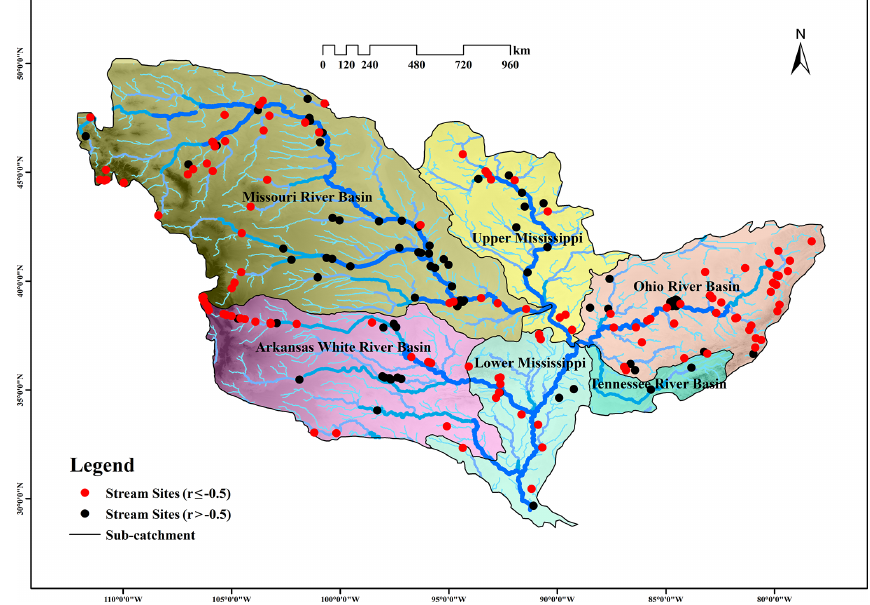
Figure 3. Spatial distribution of data analysis points within the Mississippi River basin according to the correlation between conductivity and stream